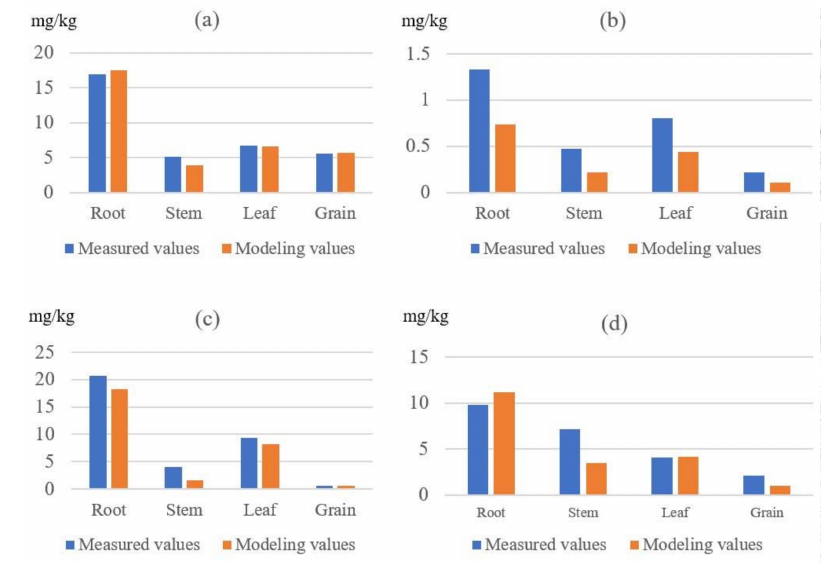
Figure 6. Root mean squares (RMS) of measured values and modeling values, ( a ) the RMS of Cu, ( b ) the RMS of Cu, ( c ) the RMS of Cu, ( d ) the RMS of Cu. The value difference rate (V DR ) was calculated based on RMS, and fluctuation difference rate was calculated based on CV (Figure 7). Modeling results were shown to be relatively good, average value difference rate is 25.29%, average fluctuation difference rate is 26.38%, and modeling results are slightly stable in numerical distribution (CV mod = 0.5, CV mea = 0.63). Cu and Pb are all better simulated both on value and fluctuation, while Cd has relatively poor simulation results.